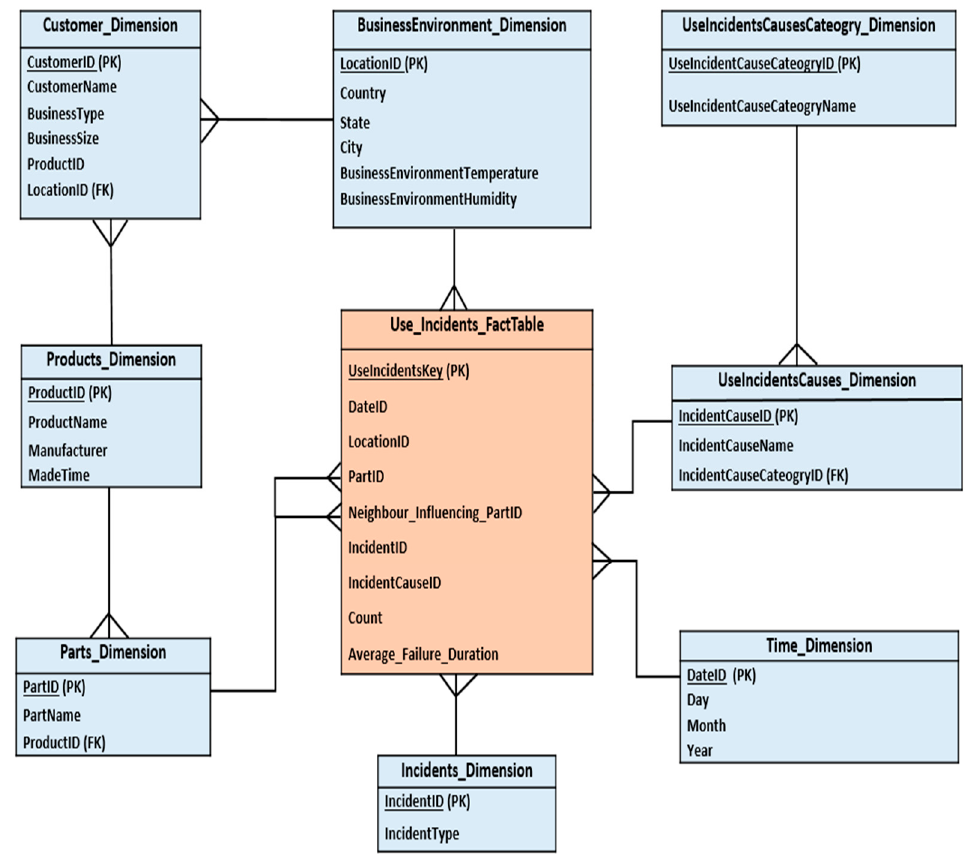
Figure 3. Proposed DW schema.